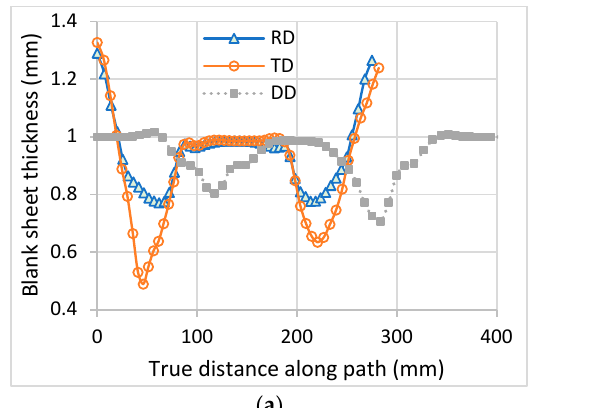
same as that presented in the experimental work of [33]. In other words, the figure can illustrate the capability of the proposed model in the damage prediction of a cross-die Figure 8. Cross-die deep drawing test. Figure 8. Cross-die deep drawing test. deep drawing test.